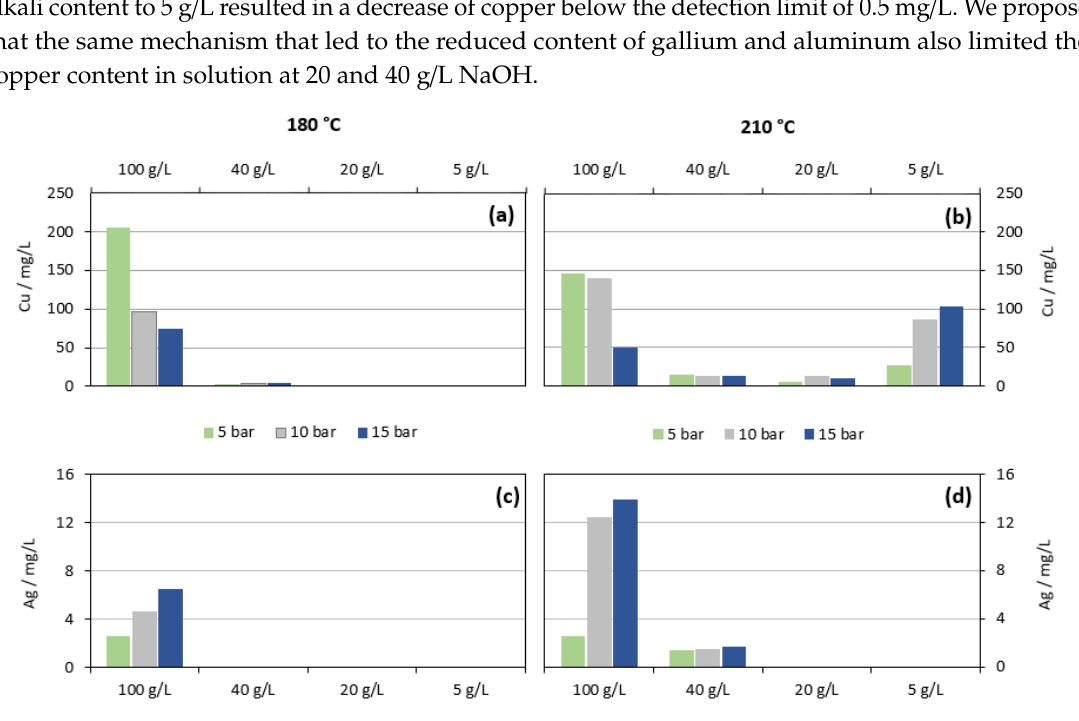
Figure 10. The copper concentration in the liquor at 180 ◦ C ( a ) and 210 ◦ C ( b ); the silver concentration in the liquor at 180 ◦ C ( c ) and 210 ◦ C ( d ); constants: 1 h, 800 rpm, S / L: 0.1. Graphs for the silver dissolution (Figure 10c,d) prove that 13.9 mg / L ( = 9.9%) silver was transferred from the fines into the liquor. As milder conditions were applied, silver was pushed below the detection limit. Unlike copper, increasing oxygen pressures facilitated silver